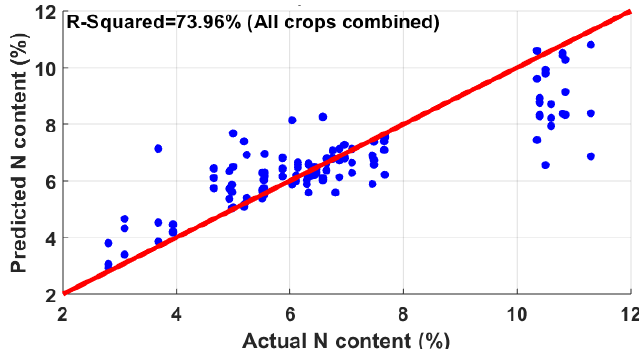
Figure 10. Nitrogen content estimation combining canola, corn, soybean, and wheat. Table 2. Five-fold cross-validation results of the N experiment. The average of the metrics from the five folds is reported.